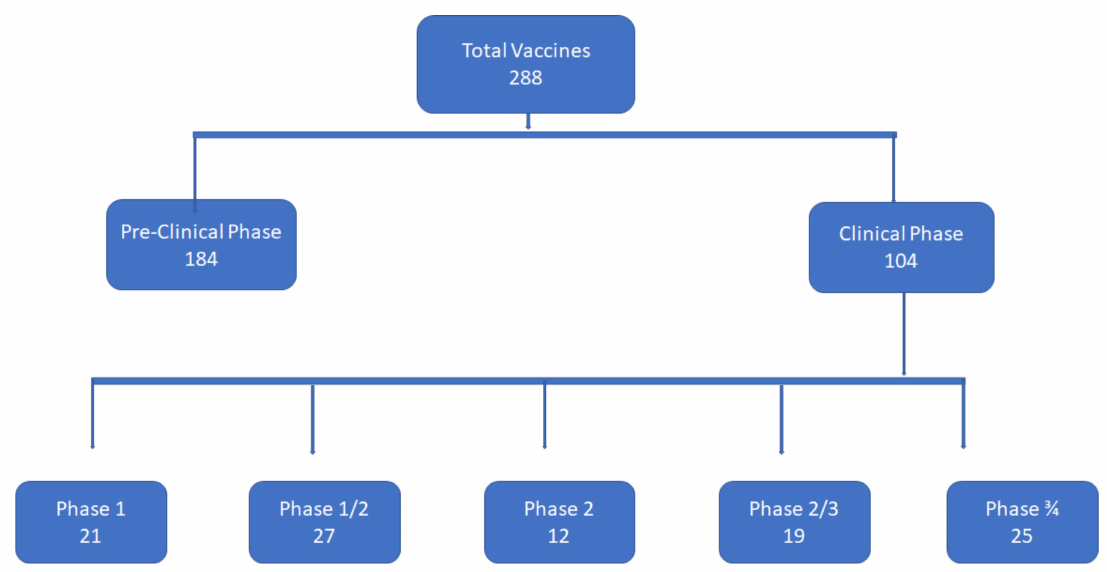
Figure 1. Vaccine development against COVID-19; number of vaccines in pre-clinical and clinical phases, in phase I, phase I/II, phase II, phase II/III, and phase